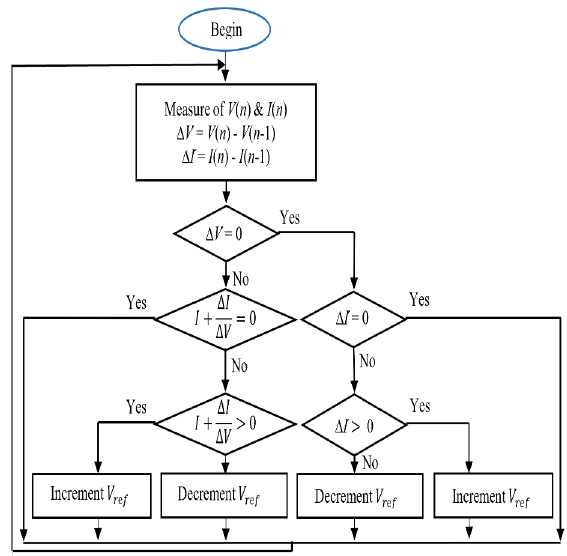
Figure 6: Algorithm associated with method INC_C